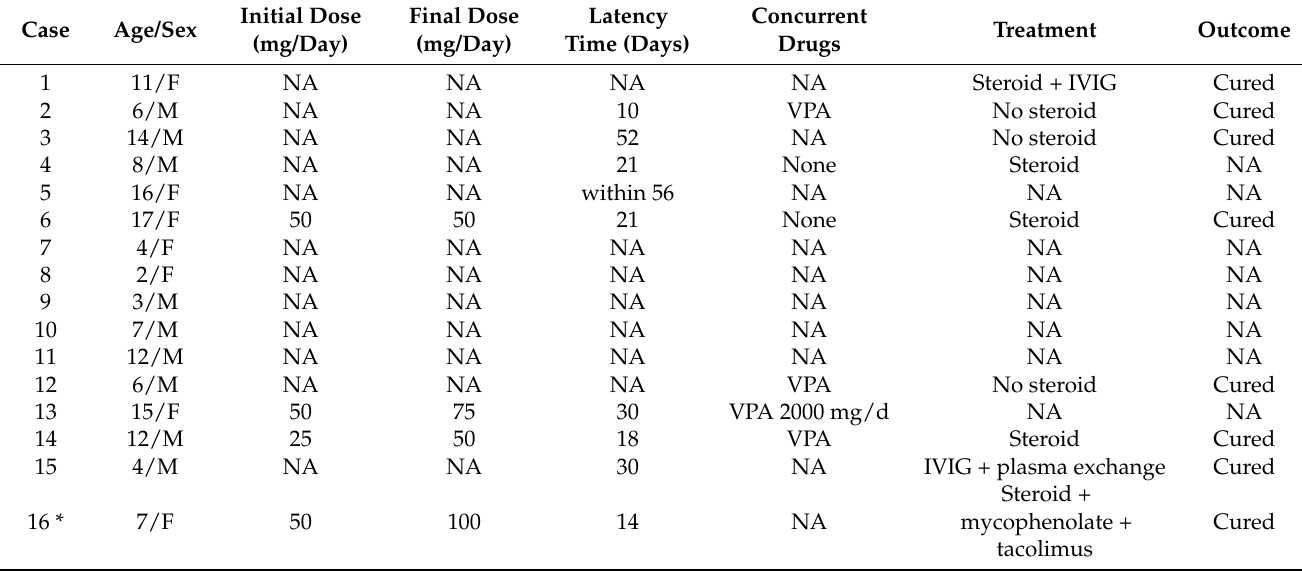
Table 1. Characteristics of children (<18 year-old) with lamotrigine-induced DIHS/DRESS in published case studies